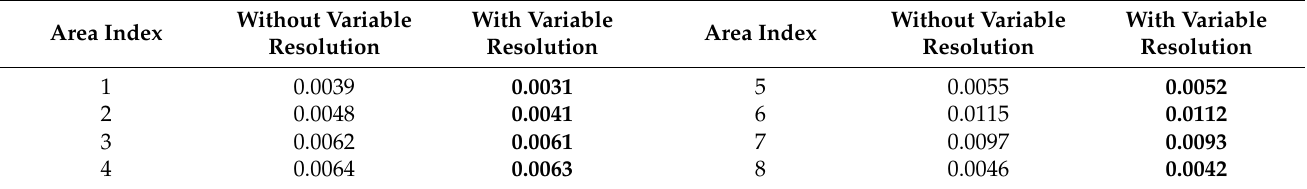
Figure 5. The selected areas of the room environment used to calculate the mapping error. Several kinds of regions are selected and colored separately, with each type of region colored in the same color. Areas 1–3 are the ceiling, areas 5 and 8 are the walls, area 4 is a piece of experimental equipment, and areas 6 and 7 are the desks. Table 3. The mapping error (MAE/m) comparison of the room environment.